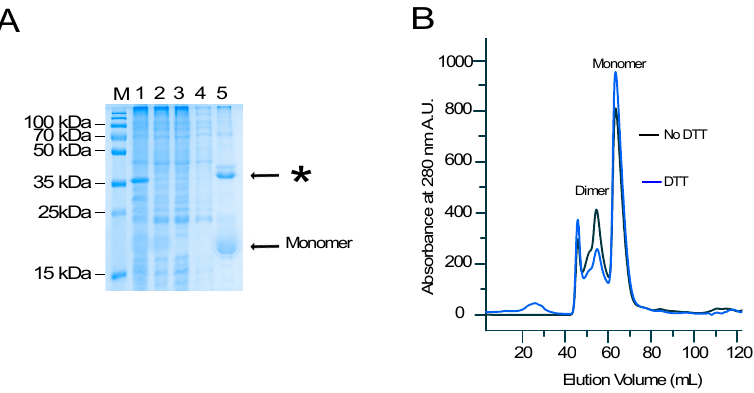
Figure 1. ( A ) Non-reducing sodium dodecyl sulfate polyacrylamide gel electrophoresis (SDS-PAGE) analysis of an affinity-purified poly Histidine-Small Ubiquitine-like Modifier protein (His-SUMO) fusion expressed in Escherichia coli ( E. coli) showing the total cellular extract (Lane 1), the soluble cell extract (Lane 2), the flow-through fraction from the nickel column (Lane 3), the wash fraction (Lane 4), and the eluted fraction (Lane 5). M: molecular weight. ( B ) Size exclusion chromatography of the HisSUMO peptide in buffer with dithiothreitol (DTT) (blue line) and without DTT (black line).